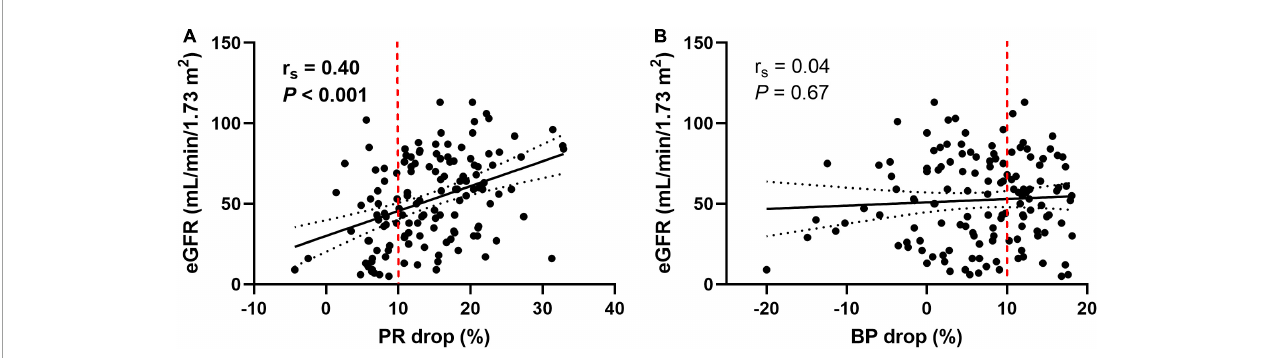
FIGURE2 Pulse rate and blood pressure drop in relation to the baseline eGFR. The pulse rate drop rate showed a positive linear correlation with baseline eGFR (A) , whereas the blood pressure drop rate did not show a significant correlation with baseline eGFR (B) . Measures of association were tested by Spearman’s correlation analysis. Solid lines indicate lines of best fit. Dotted lines show 95% confidence intervals. The dashed red line represents 10% of the pulse rate drop (A) and the blood pressure drop (B) . eGFR, estimated glomerular filtration rate; PR, pulse rate; BP, blood